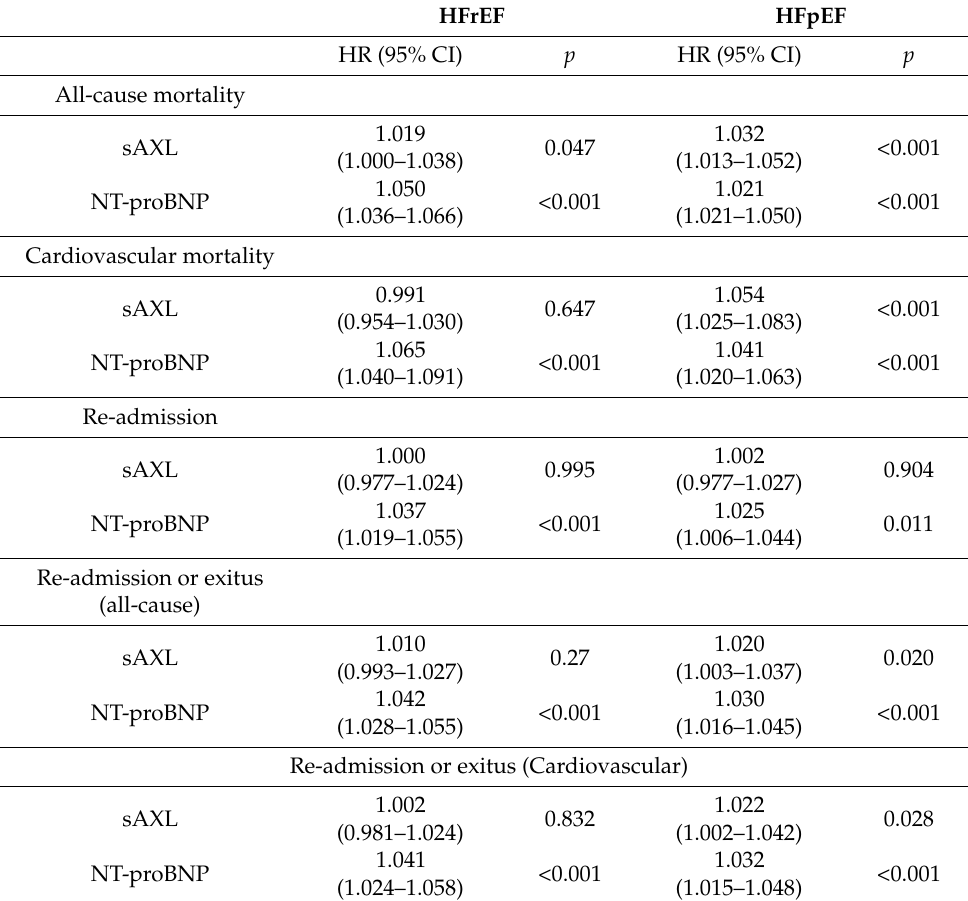
Table 2. Cox regression value for absolute